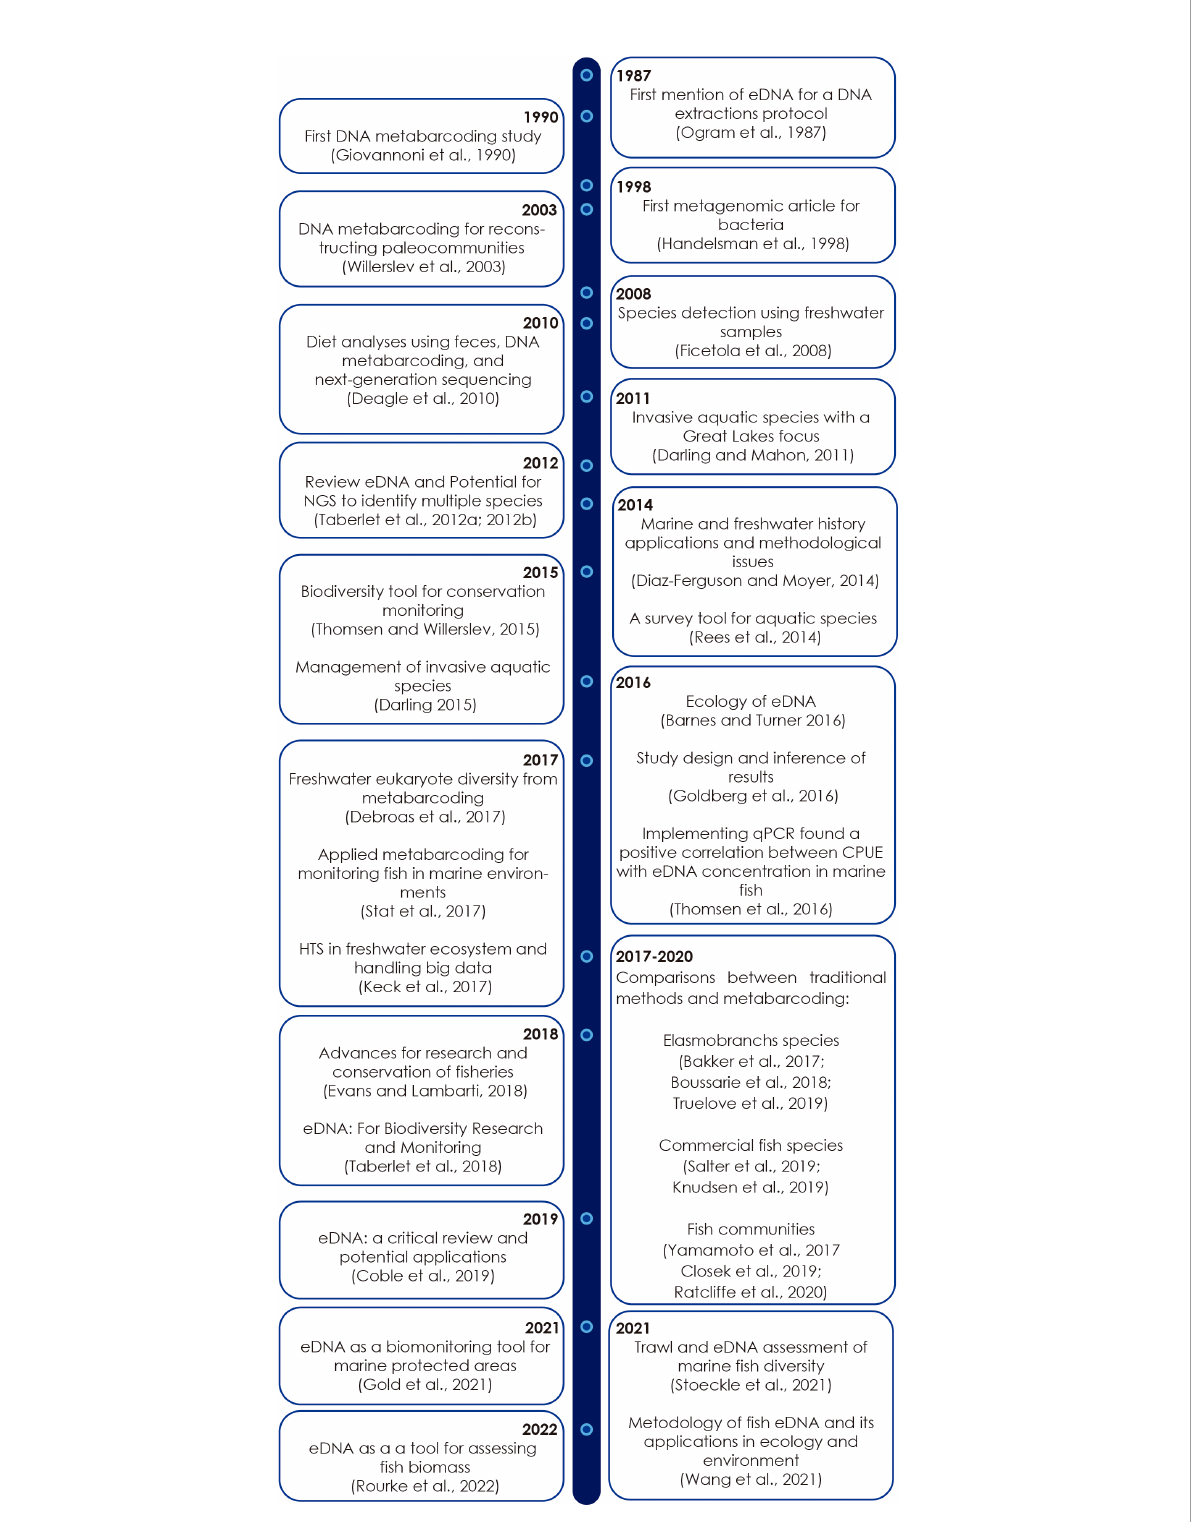
FIGURE 1 Timeline of representative eDNA literature between 1987 and 2022. The last fi ve years only consider studies of biological monitoring in marine